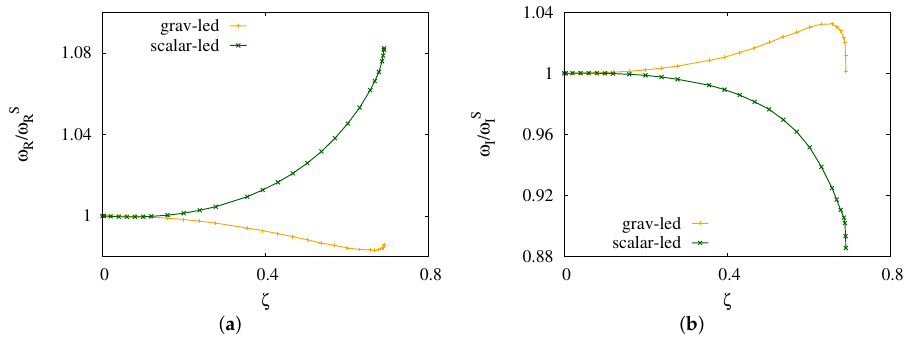
vs. dimensionless R vs. ζ = α / M 2 . Shown are the scalar-led I